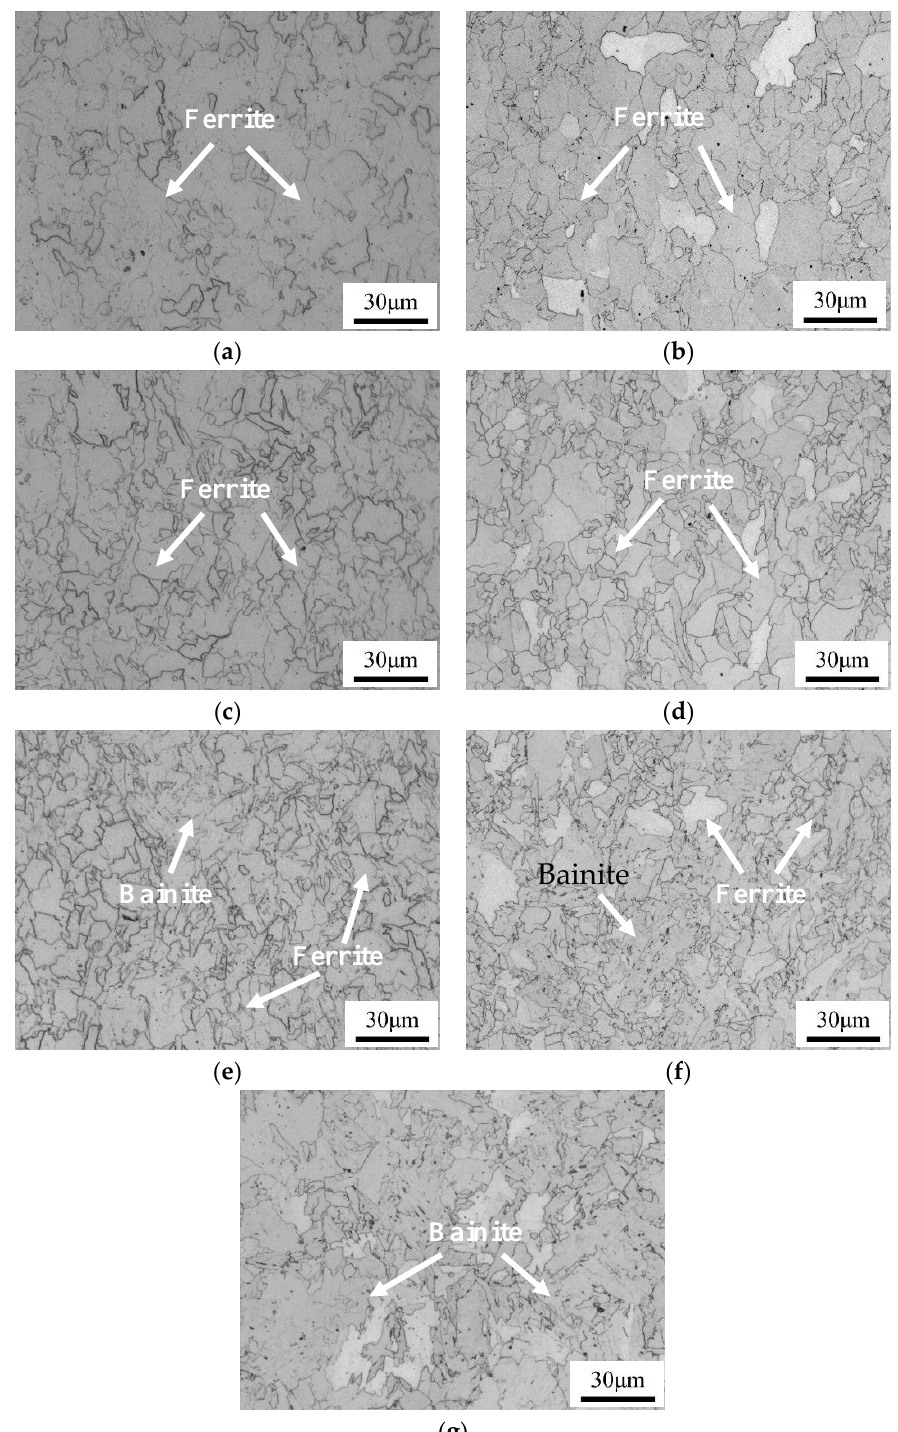
Figure 2. Optical microstructure of Cu-free and Cu-bearing steels at different cooling rates. ( a , c , e ) 0.05, 0.2 and 5 °C/s for Cu-free steel, respectively, ( b , d , f ) 0.05, 0.2 and 5 °C/s for Cu-bearing steel, respectively, ( g ) as-quenched condition for Cu-bearing steel.